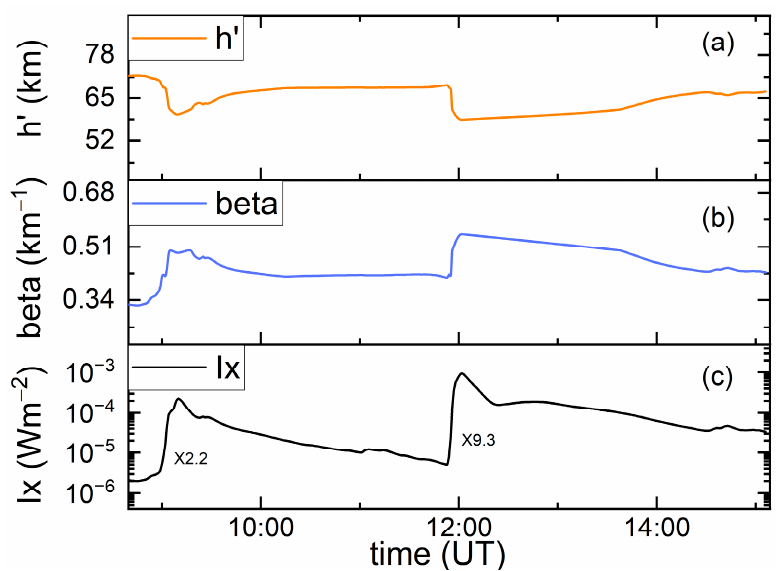
Figure 4. Simultaneous variations of the effective reflection height h ’, ( a ) sharpness β , ( b ) and X-ray flux ( c ) during the occurrence of two successive X-ray flares of 6 September 2017.